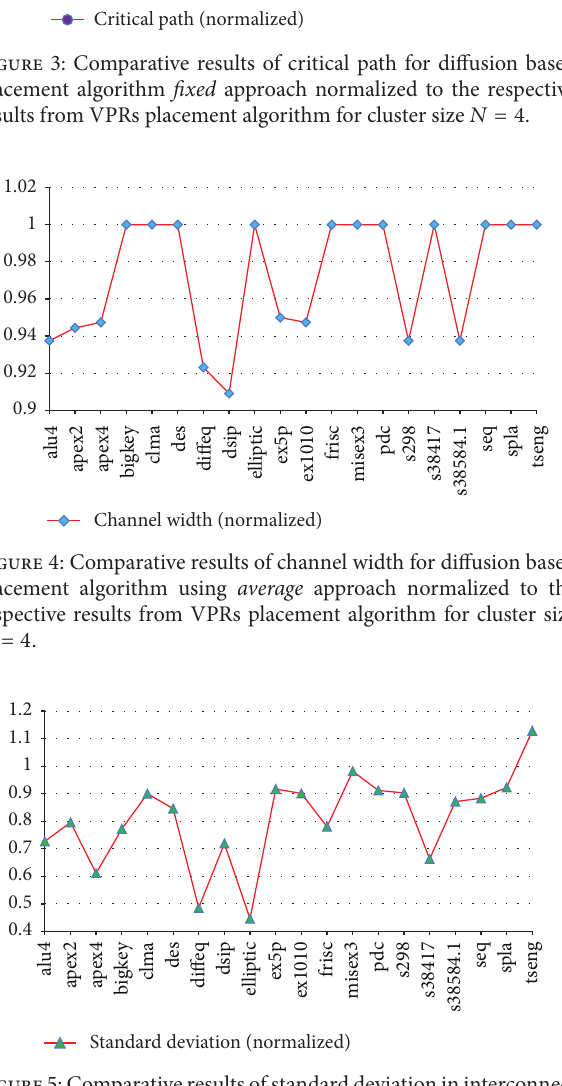
Figure 5: Comparative results of standard deviation in interconnect demand for diffusion based placement algorithm using average approach normalized to the respective results from VPRs placement algorithm for cluster size 𝑁 = 4 .